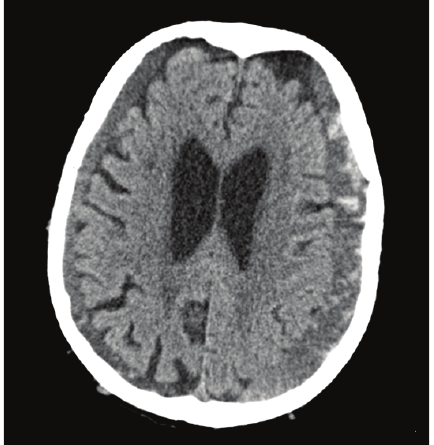
Figure 1: Axial nonenhanced cranial CT scan performed on admis- sion, showing bilateral subdural hematoma with signs of recent